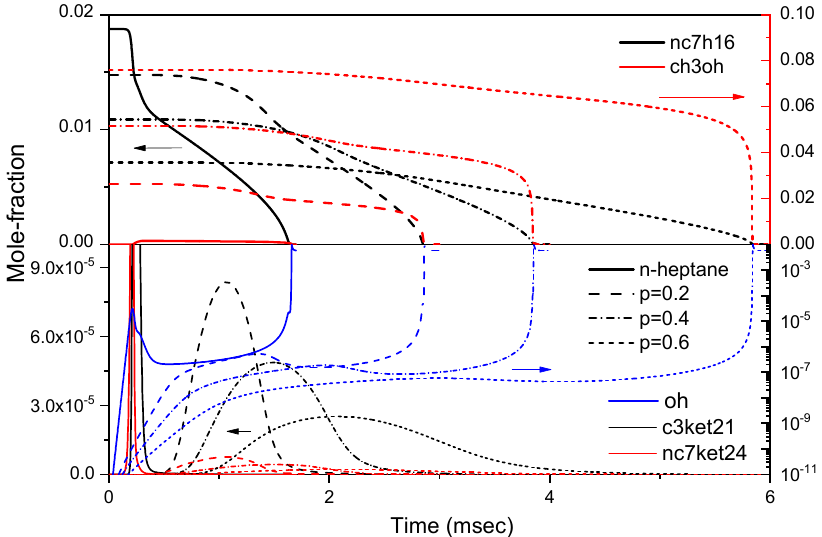
Figure 2. Under low temperature, the concentration change curve of the fuel substance. When MSP = 20%, the peak concentration of OH in the low-temperature exothermic phase was 100 times lower than that in pure n-heptane. The higher the methanol substi- tution rate, the more suppressed the increase in the OH radicals in the low-temperature exothermic